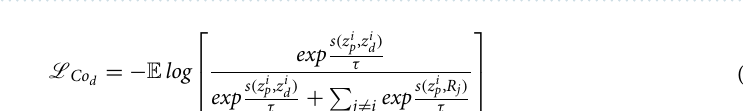
The expectation in L Co is over all positive pairs { z i p , R i } n i = 1 from the joint distribution p ( z , R ) and likewise p for L Co . τ > 0 is a scalar temperature hyperparameter. The k-negatives: { R j } are randomly retrieved from M j �= i d and are the encodings of prior-views v p of other instances. These negatives are advantageous for two reasons. (a.) Over time, sampling R j from M automatically allows mining harder negatives as over the course of training, the memory bank representations { R j } n j = 1 specialize in local pathological regions and discriminating between ( z i p , R j ) amounts to discriminating between finer features that characterize pathologies. (b.) When retrieving negatives from M instead of the input batch, the number of negatives gets decoupled from the batch size. The total objec- tive is a weighted sum of losses in Eqs. (1) and (2) with scalar parameters α = β = 0.5 , shown in Eq. (3). The